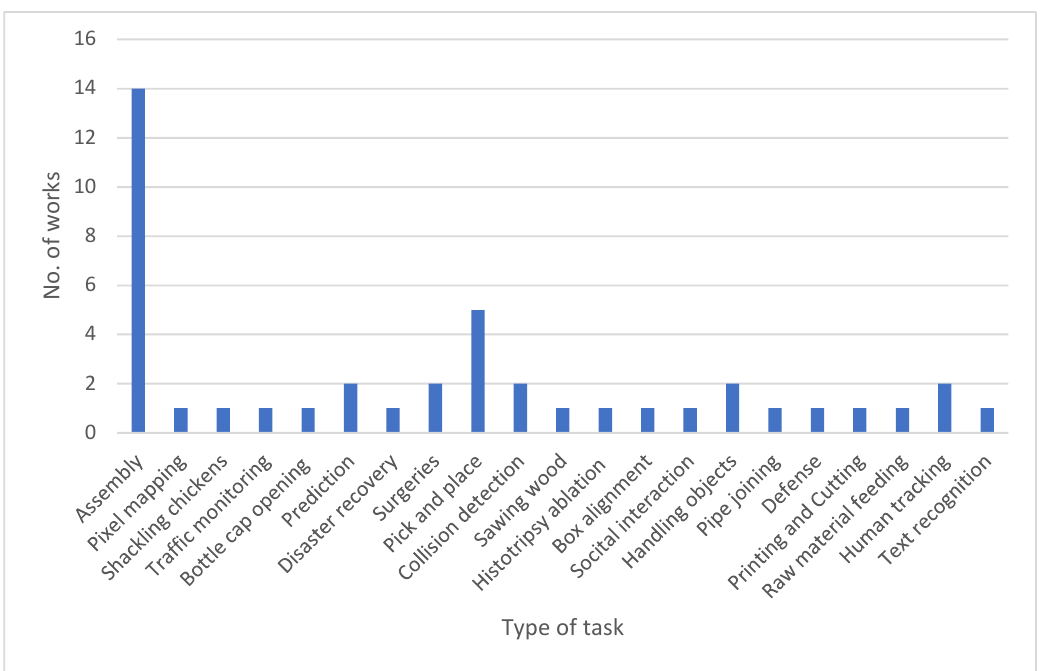
Figure 5. Robot usage in collaborative research works between 2018 and 2022.